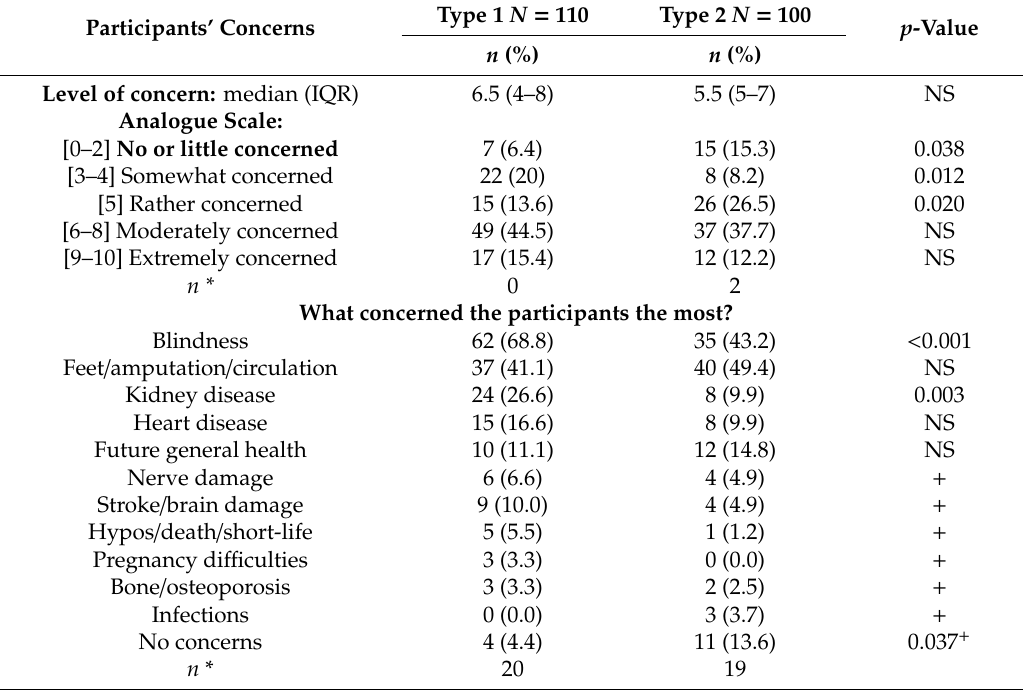
Participants’ level of concern regarding developing potential diabetes-related health